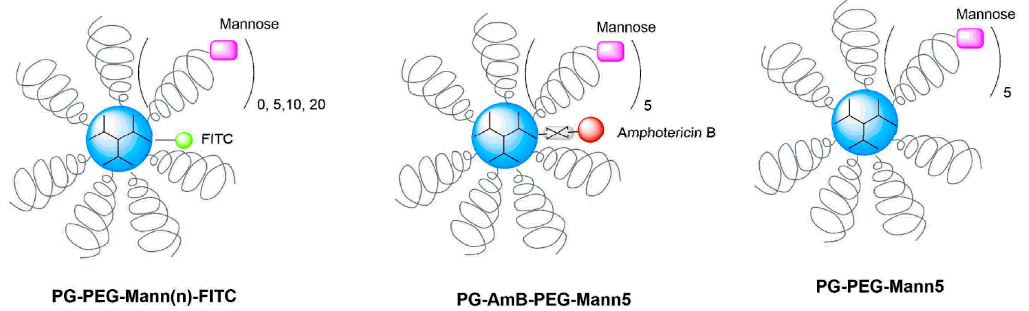
Figure 1. Schematic representation of the PG–PEG–Mann(n) products.